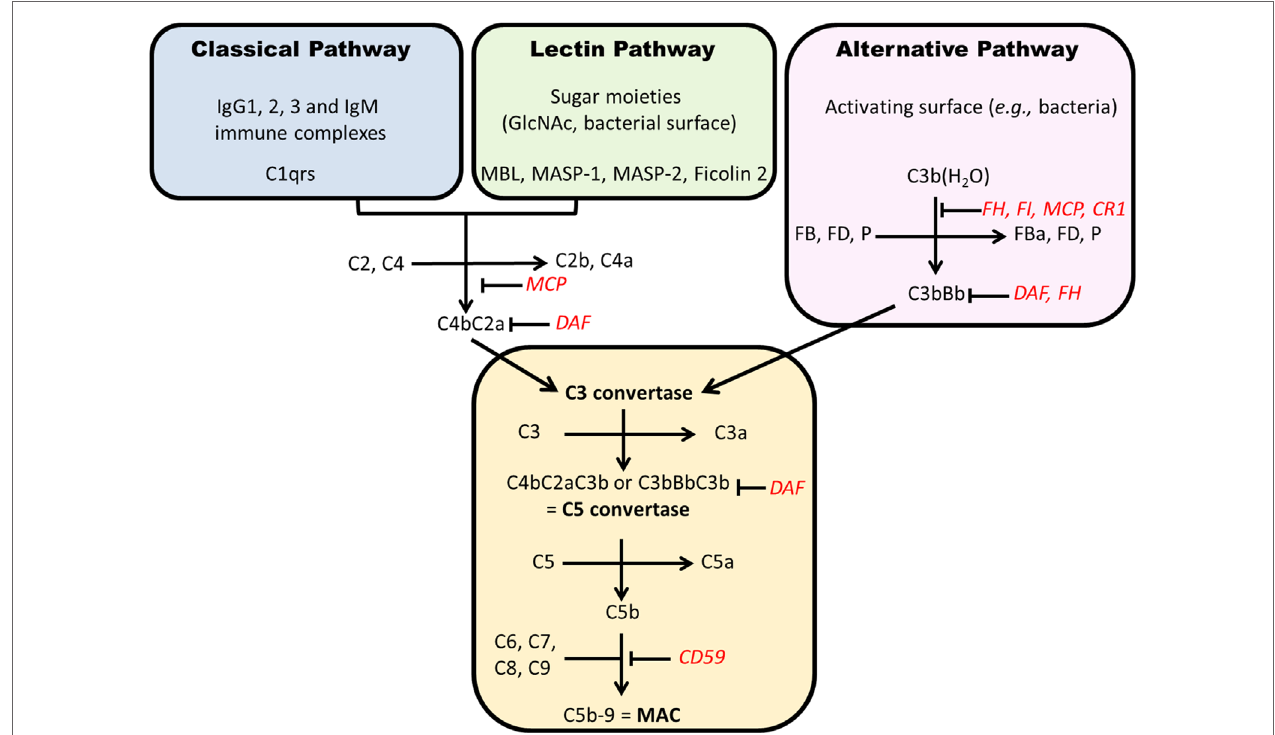
FiGURe 5 | Complement activation pathways . Each pathway results in formation of a C3 convertase that, after addition of C3b, becomes a C5 convertase. The generation of C5b starts the formation of membrane attack complex (C5b–9). Regulatory factors are in red. CR1, complement receptor 1; FD, factor D; MAC, membrane attack complex; MCP, membrane cofactor protein; P, properdin; DAF, decay accelerating factor; MBL, mannan-binding lectin; MASP, MBL-associated serine